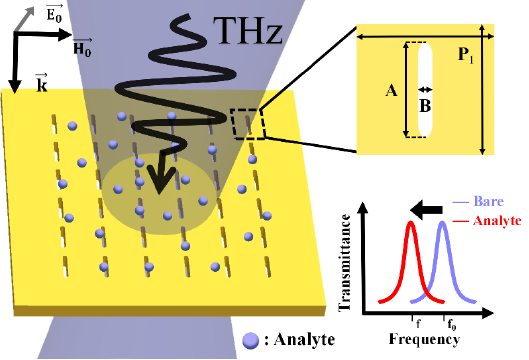
Figure 1. Schematic diagram of metallic slot array metamaterial biosensing. To achieve THz resonance-enhanced sensing of UA, the resonance peak of the met- amaterial needs to be modulated to coincide with the frequency of the characteristic peak of UA. The characteristic terahertz spectrum peak of UA is located at 1.5 THz [29], while AA is at 1.8 THz [30]. Metamaterial SPR resonant response modes are derived from their array structures by artificial design, so the array cell size of MSA metamateri- al is significant. In our initial simulations, we observed an apparent EOT phenomenon in the circular hole structure at 0.88 THz-2 THz for a hole aperture of 87 μm. As shown by the black line in Figure 2a, the transmission spectrum exhibits a resonance peak with 99% transmittance, but a widened full width at half height (FWHM) at 1.7 THz. The quality factor (Q) defines the degree of energy loss in the system during one cycle, which is an important evaluation parameter correlated to the sensor performance. According to the calculation equation: Q = 𝑓 0 FWHM (2) where 𝑓 0 is the center frequency of the resonance peak. Lower Q values imply higher en- ergy loss in the system due to higher FWHM. According to Figure 2a, by compressing a hollow circular hole (B) into a hollow slot, the FWHM of the resonance peak at 1.7 T can be shortened and the Q value can be increased by 2.53 to 8.49. 1.0